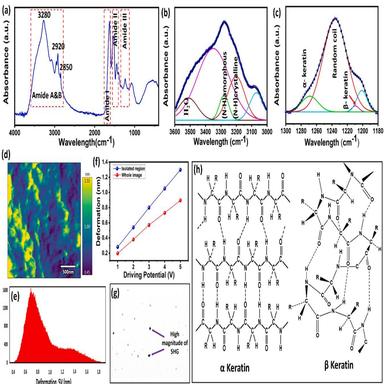
(a) The FT-IR analysis of the snake ecdysis. The deconvolution analysis of the (b) 3000–3600 and (c) 1180–1300 cm− 1 regions. (d) Piezoresponse force microscopy image, 2.5 × 2.5 µm, taken from the ridge in b, showing the z-deformation under a 5 V driving potential, showing relative values of the d33 piezoelectric coefficient. (Different driving potential demonstrated in Supplementary Fig. S4) Bright regions indicate isolated areas of high piezoresponse. (e) Histogram of the image in d, showing the bi-modal